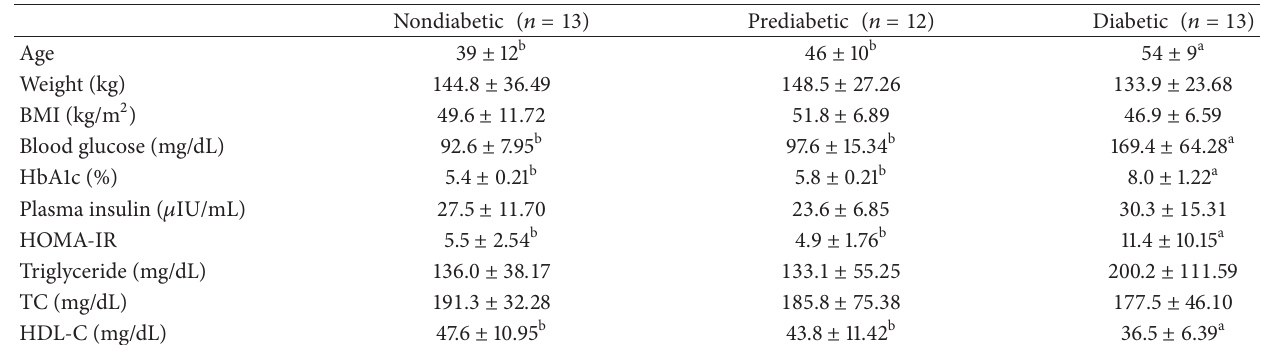
Table 1: Characteristics of nondiabetic, prediabetic, and diabetic subjects ¥ .